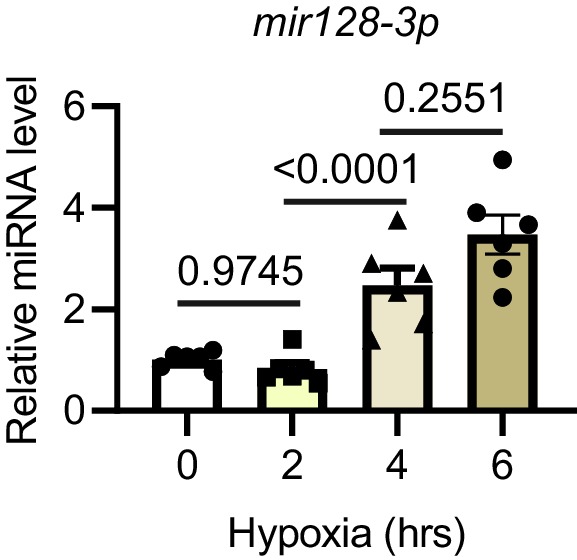
Mir128-3p level in rat cardiomyocytes after hypoxia.Mature mir128-3p was measured using TaqMan Advanced miRNA qPCR (N = 6 experiments). Data were normalized against mature mir191-5p expression. Data presented as mean ± SEM. Groups were compared using one-way ANOVA followed by Bonferroni post hoc tests.Figure 2—figure supplement 2—source data 1.Mir128-3p level in rat cardiomyocytes after hypoxia.